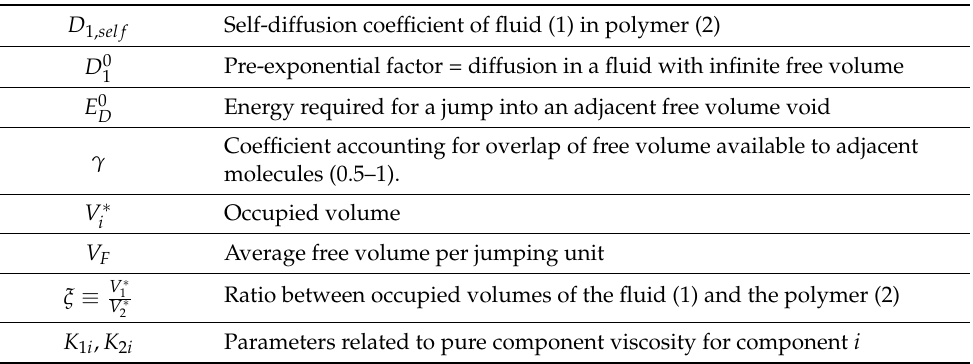
Table 4. Variables and parameters in the self-diffusion coefficient expression given by the Free-Volume Theory (Equation (46)). D 1,